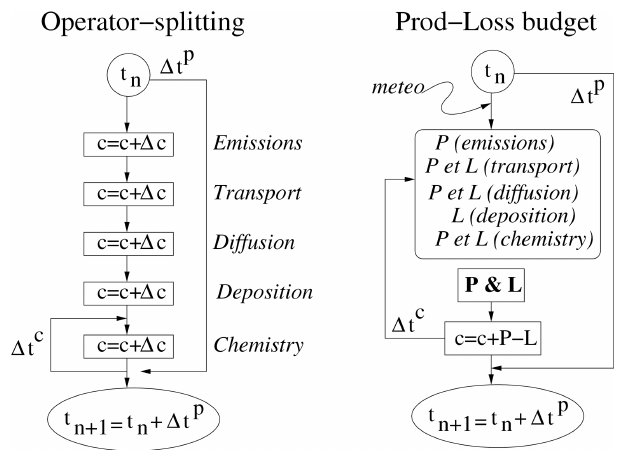
Figure 14. Principle of the time integration in the model of all pro- cesses calculated to update the chemical concentration